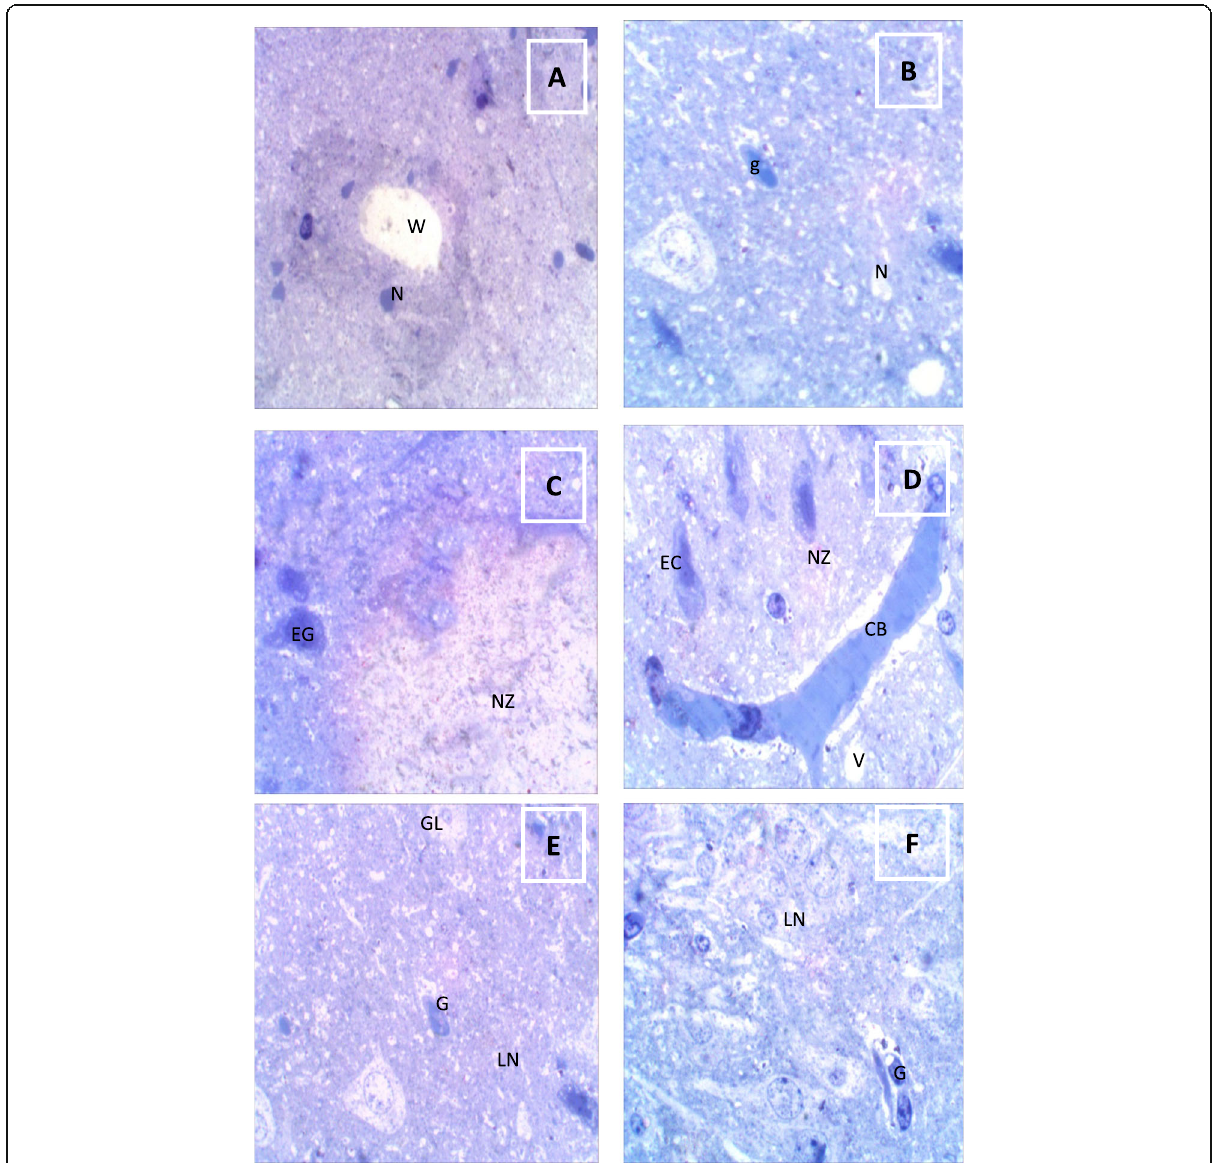
Fig. 5 Semi thin sections of the brain with toluidine blue stain. a Control normal appearance of brain tissues with normal white matter (W) and neurons. b LC-treated rats showed normal appearance of brain tissues with normal neurons (N) and glial fibers (g). c ASP-LD treated-animals, necrotic zone (NZ), and enlarged swollen glial fibers (EG) appeared. d ASP-HD group showed that the brain tissues had necrotic zone (NZ) and highly congested blood vessel (CB) with vacuoles (V) and enlarged blood capillary (EC). e ASP-LD + LC group showed the brain tissues with less necrotic zone (LN) and normal glial fibers (G) with perinuclear Golgi complex (GL). f ASP-HD + LC: Brain tissues with normal appearance of brain tissues and normal glial fibers (G) and less necrotic area (LN) with some fatty